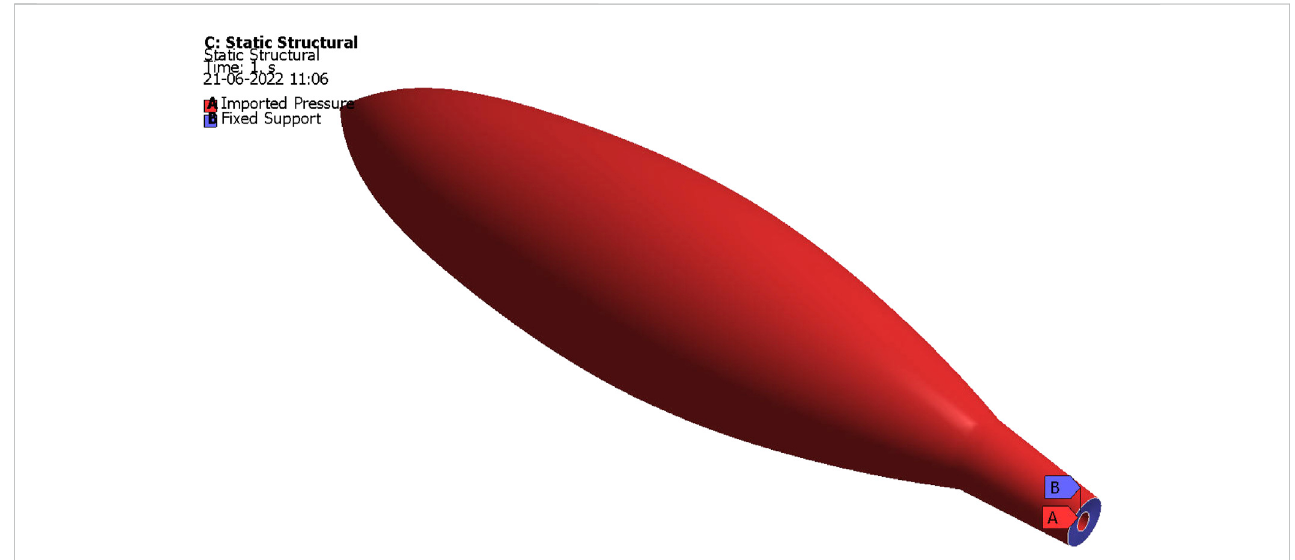
Detailed boundary conditions imposed on full fuselage model for FEA.